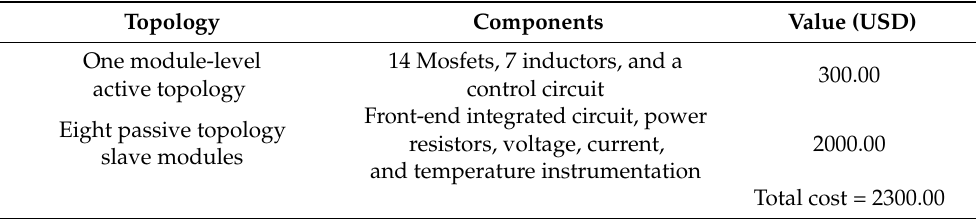
Table 4. Approximate cost for building the hybrid topology to be active at the stack level and passive at the cell